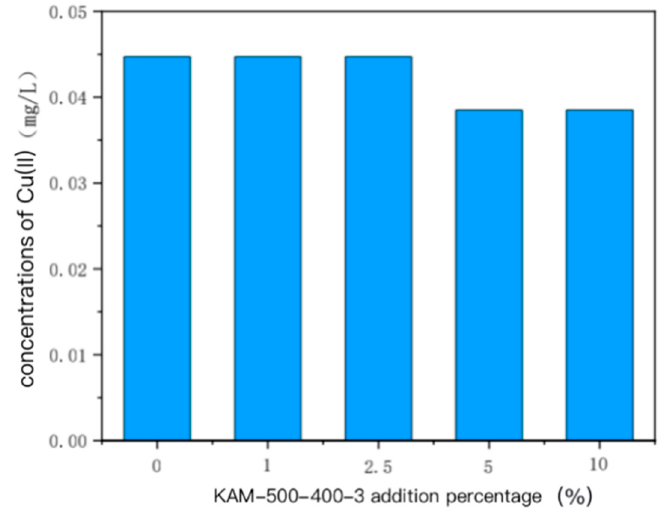
Figure 2. Effect of KAM-500-400-3 addition percentage on the concentrations of Cu(II) in the overlying water of single Cu(II)-contaminated sediment.